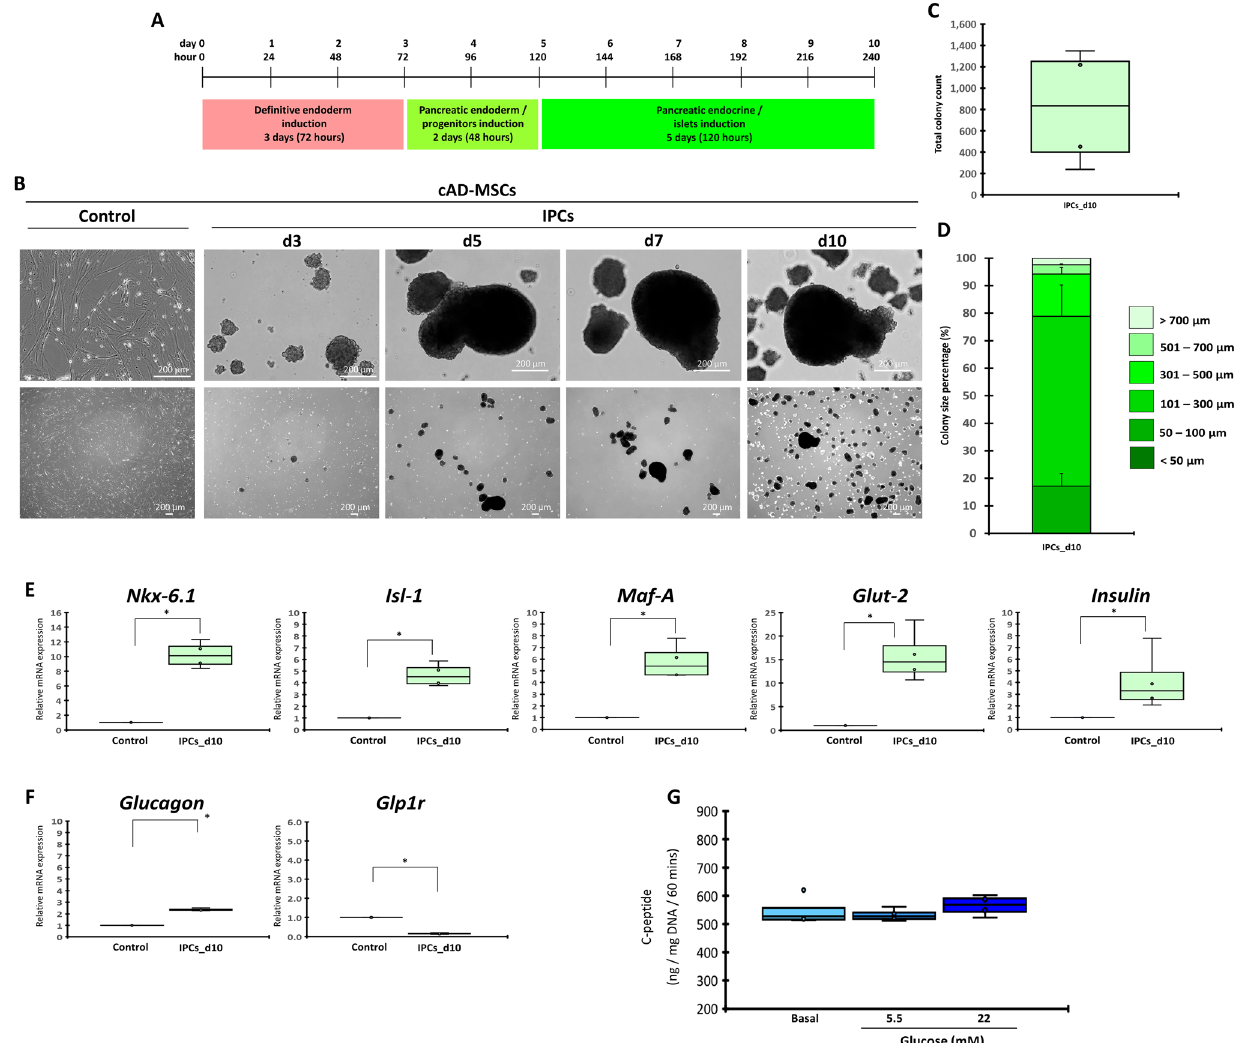
Figure 5. Generation of cAD-MSC-derived IPCs by microenvironment manipulation. Diagram of culture technique used for the generation of cAD-MSC-derived IPCs is shown in ( A ). Morphological appearances of cells that underwent induction technique were observed under phase-contrast microscope with magnification of 40X and 200X ( B ). Total colony number ( C ) and colony size proportion ( D ) were evaluated. mRNA markers relating to pancreatic beta-cell ( E ), and pancreatic-relating markers ( F ) were analyzed by RT-qPCR. mRNA expression was normalized with reference gene and undifferentiated control. Functional testing by glucose-stimulated C-peptide secretion (GSCS) was illustrated ( G ). Bars indicate a significant difference (*, p value < ( Glucagon ) of the DAPT-B group was much lower than that of the DAPT-A group. Glp1r was downregulated in all conditions (Fig. 7C). Interestingly, the analysis of Notch target genes Hes-1 and Hey-1 showed that the DAPT-B group showed significant upregulation of both genes compared with others (Fig. 7D). Functional testing showed that cAD-MSC-derived IPCs from the DAPT-B condition yielded the highest basal C-peptide secretion as well as the higher glucose-responsive C-peptide secretion upon low (5.5 mM) and high (22 mM) glucose stimulation compared with the control and DAPT-A groups. Due to variation between the groups, the statistical difference within each group was not found (Fig. 7E). An additional analysis on the protein expression of the crucial pancreatic endocrine hormones Insulin and Glucagon was performed using immunocytochemistry staining. The results suggested the expression of both proteins by the colonies collected from cAD-MSC induc- tion (Figs. 7F,G). To affirm that the IPCs derived from cAD-MSC induction were able to secrete insulin upon culture medium maintenance, DMEMs supplemented with various glucose concentration (0, 5.56, and 25 mM) were used. The results suggested a similar trend of insulin secretion, as previously illustrated in the functional analysis (Supplementary Figure S1). Taken together, the results suggested that cAD-MSC-derived IPCs could be efficiently generated using the microenvironment-manipulating approach with Notch optimization. The obtained IPCs from Notch inhibition